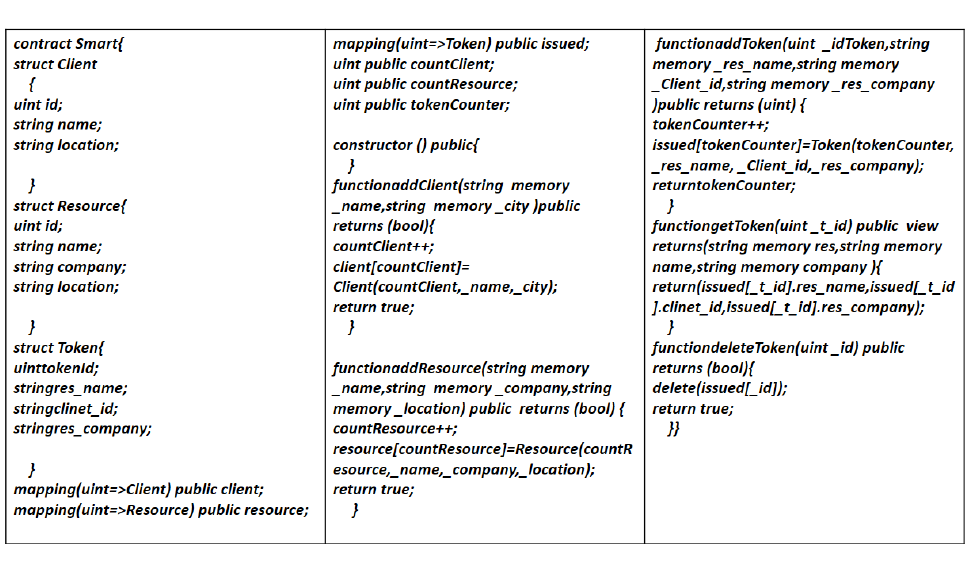
Figure 11. Sample smart